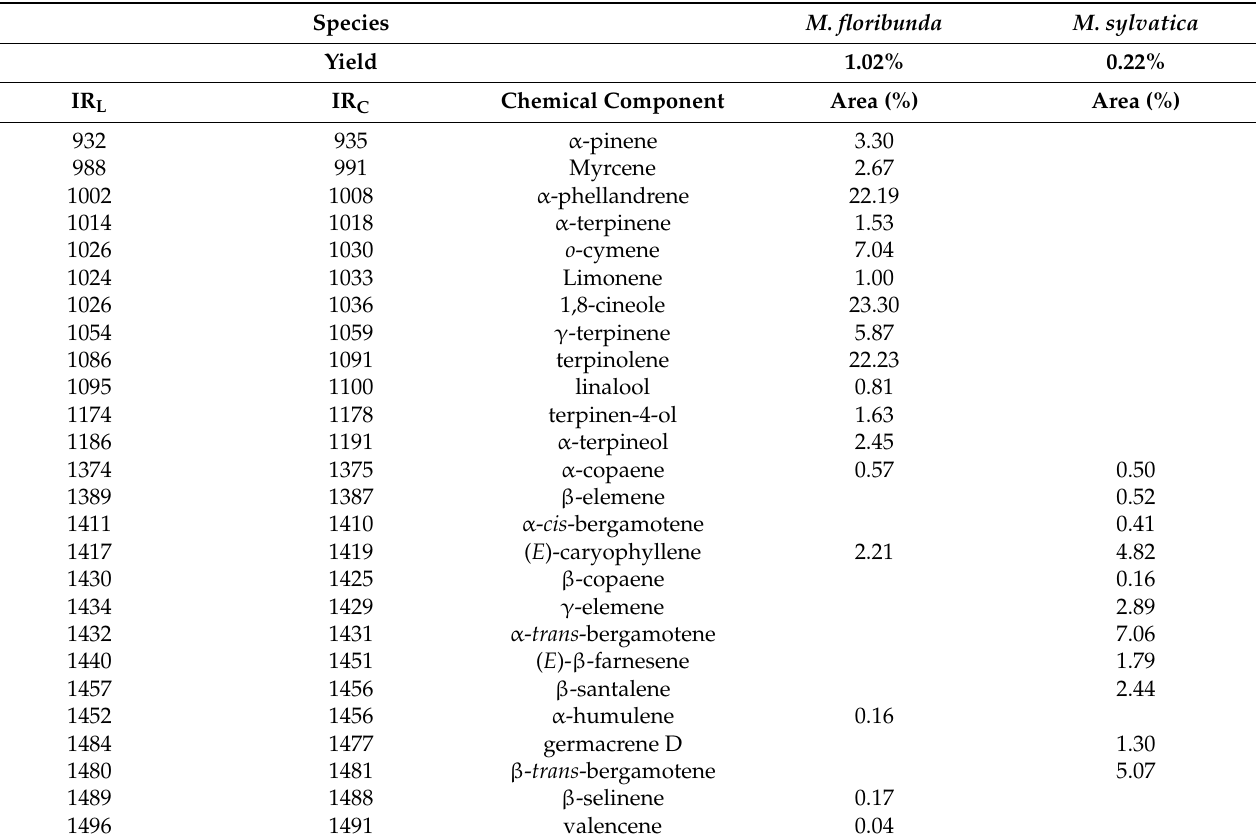
Table 1. Chemical composition of the essential oils of the two species of